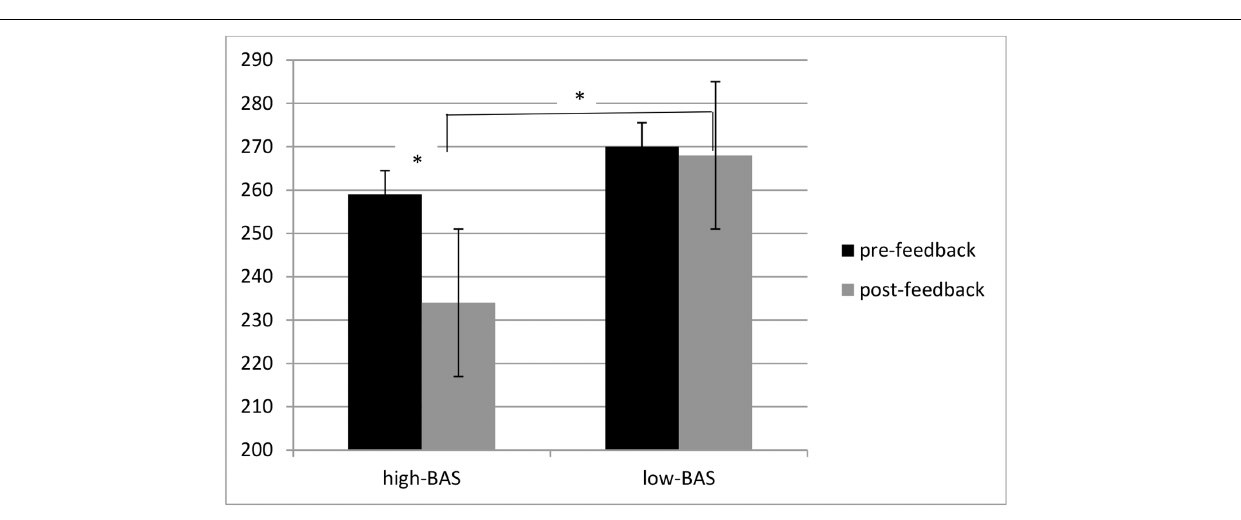
FIGURE 4 | Response times (RTs) modulation as a function of BAS and Condition. High-BAS subjects showed decreased RTs in post-feedback compared to pre-feedback condition, and reduced RTs compared to low-BAS during post-feedback condition. Asterisk indicates significant